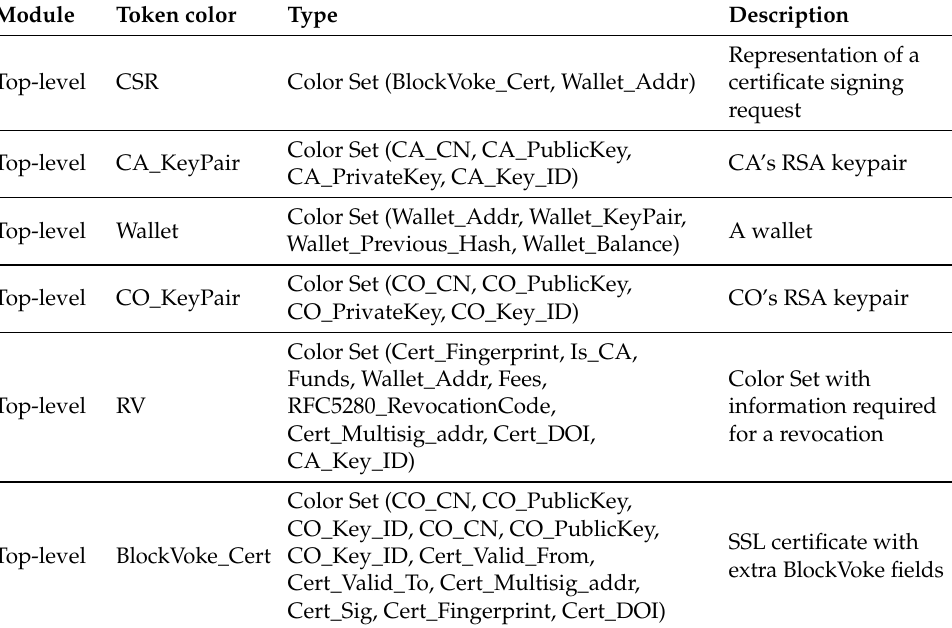
Table 5. The first column specifies the module of the first occurrence of a certain acronym, name or token color, while the second column specifies its name. The third column details the data type and structure. The last column provides a short description. A complete listing is available in Appendix A. Table 5. Acronyms, names and token colors of BlockVoke’s top-level CPN